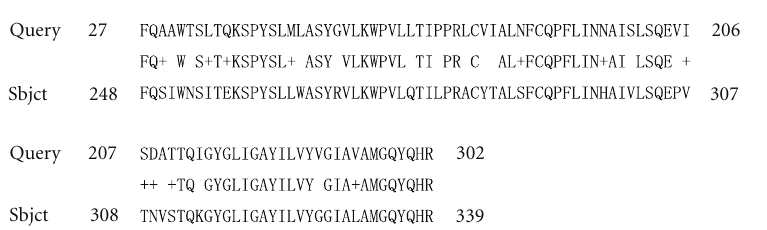
gb | AEO61238.1 | ABC transporter [ Myceliophthora thermophila ATCC 42464] Length = 1482 Score = 140 bits (352), expect =